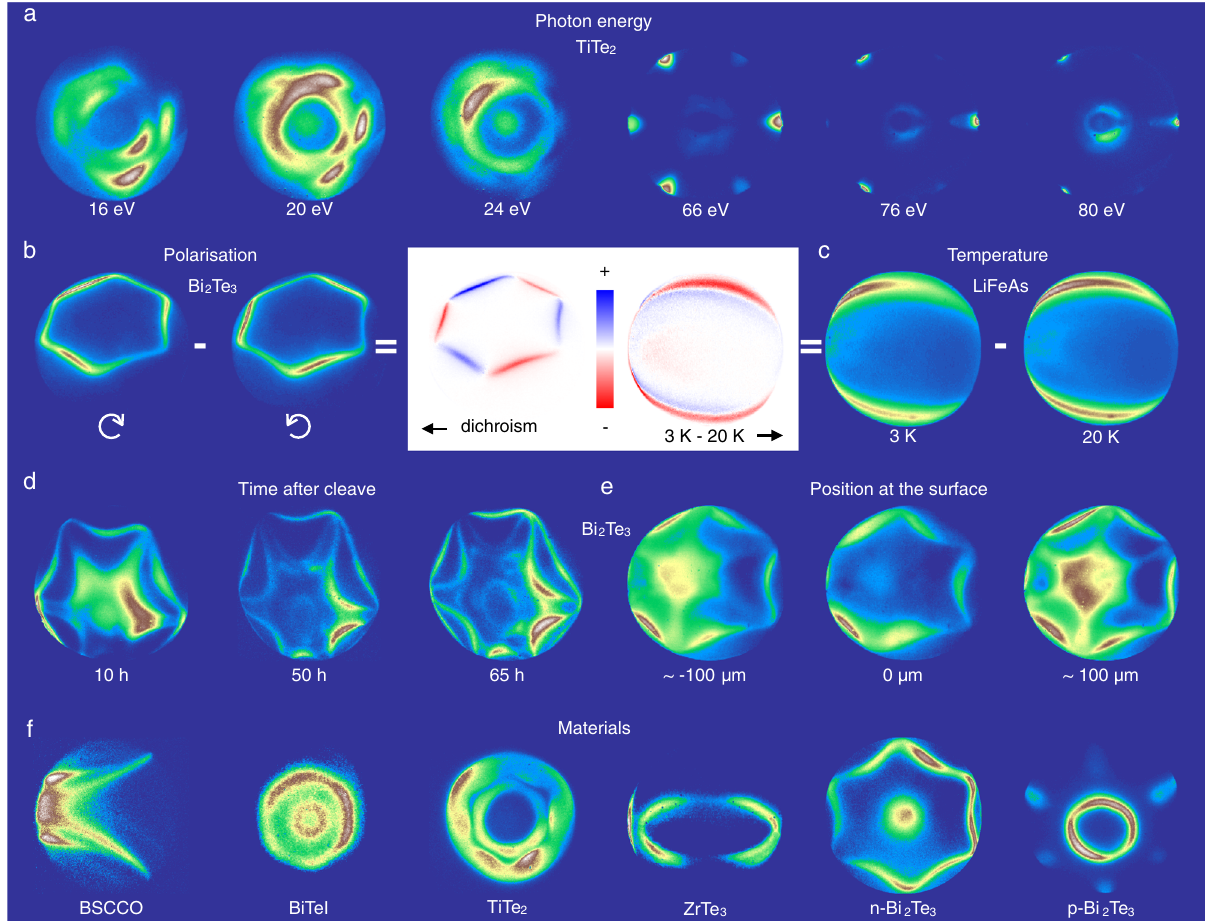
Fig. 3 Two-dimensional Fermi surface maps. Angular distributions, typically 500×500 pixels, of the photoemission intensity within the solid angle of ~30° and kinetic energy interval 5-20 meV in the vicinity of the Fermi level. a Angular distributions from TiTe 2 recorded at two synchrotron light sources. Lower energies - BESSY (6 K), higher energies - ASTRID2 (35 K). b Off-normal (~5°) emission laser (6 eV) data from Bi 2 Te 3 . recorded using left- and right-hand circularly polarized light, as well as their difference. T = 3 K. c Temperature-dependent data from LiFeAs and their difference. d Off-normal (~3°) emission data from Bi 2 Te 3 recorded at different time after cleavage. T = 3 K. e The same as d , but taken earlier (after ~5 h) and from different positions at the cleaved surface. f Angular distributions from different materials. First four maps are recorded at BESSY at approximately 6 K. Two other maps — in the laboratory using the laser at 3 K.